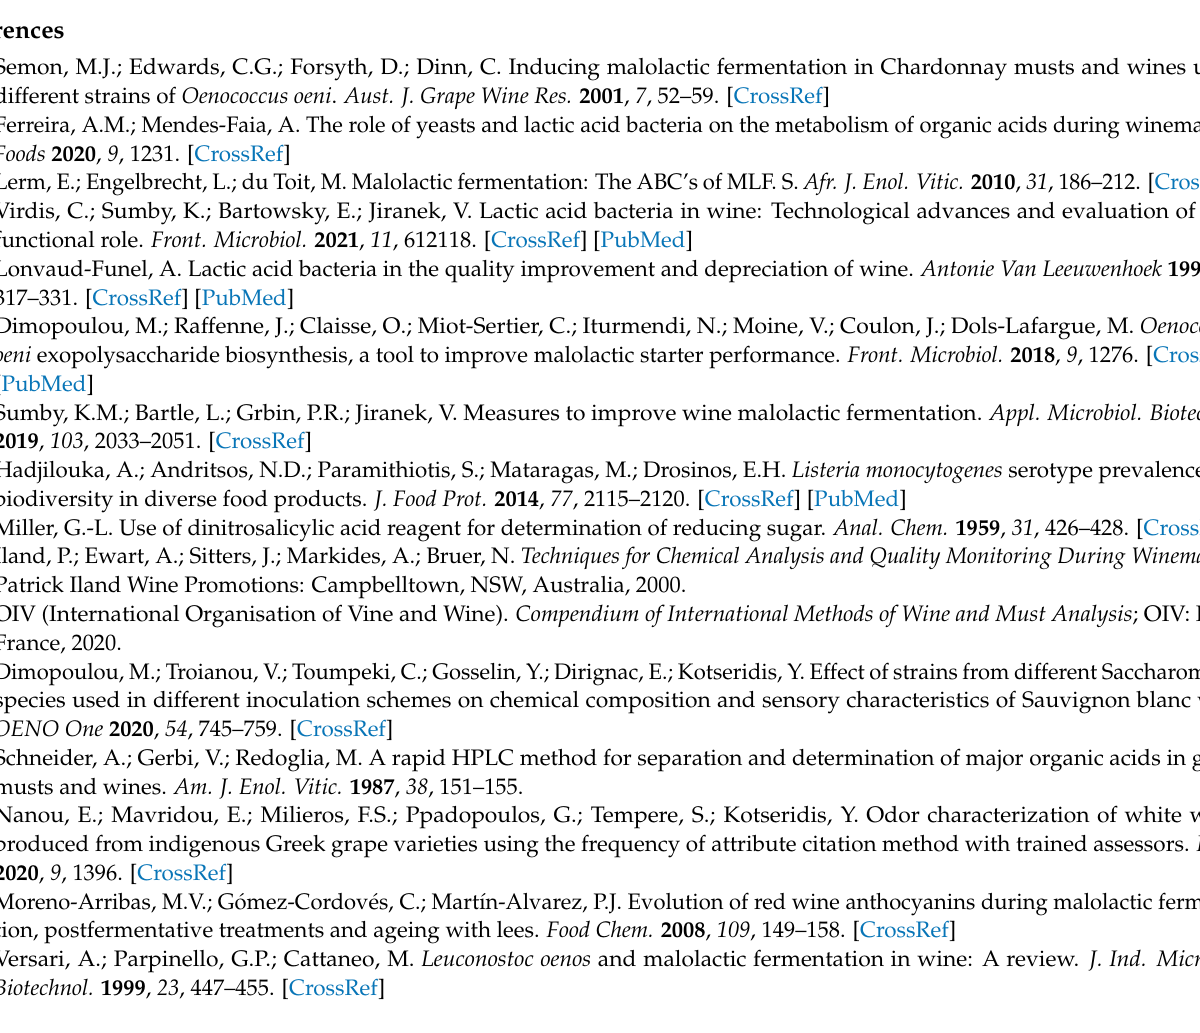
Figure S2: LAB population (in log CFU/mL) during spontaneous MLF (yellow), or after inoculation with Oenococcus oeni strains Viniflora ® CH16 (blue), Viniflora ® Oenos (green) and Viniflora ® CiNe (red) during white (A) and ros é (B) winemaking; Figure S3: Reducing sugars consumption during alcoholic fermentation of Moschofilero must for white (yellow) and ros é (red) winemaking by Saccharomyces cerevisiae strain UCLM